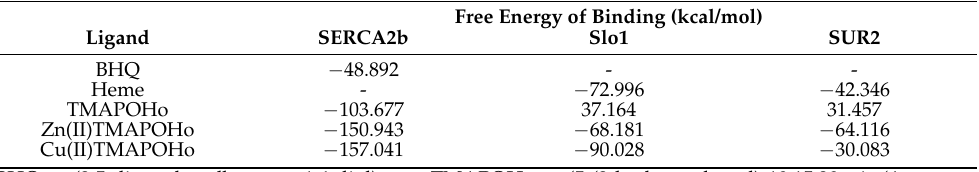
Table 2. Free energy of binding for positive controls and assessed porphyrins after 500 ps MD simulations.